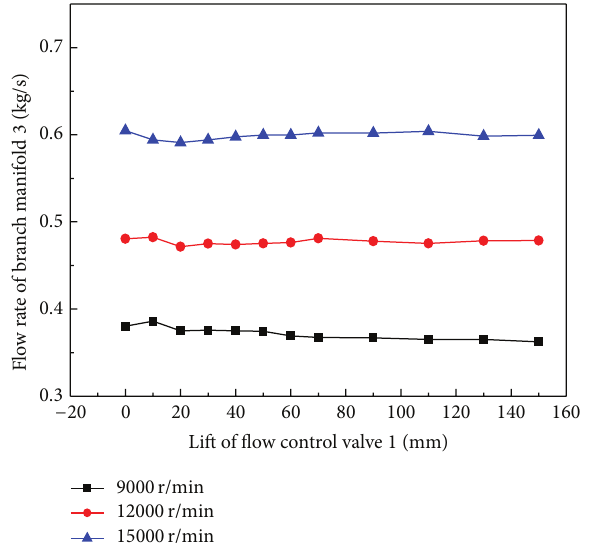
Figure 5: Flow rates in branch manifold